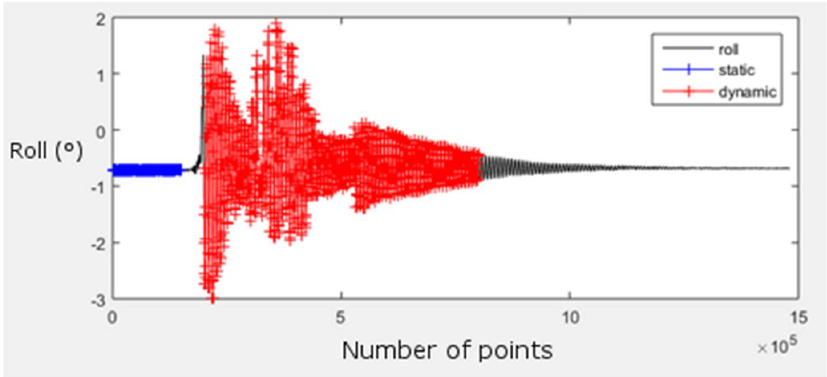
Figure 7. The two subsets used to calculate uncertainty and accuracy associated with height measurements: an angular static dataset (blue) and an angular dynamic dataset (red).